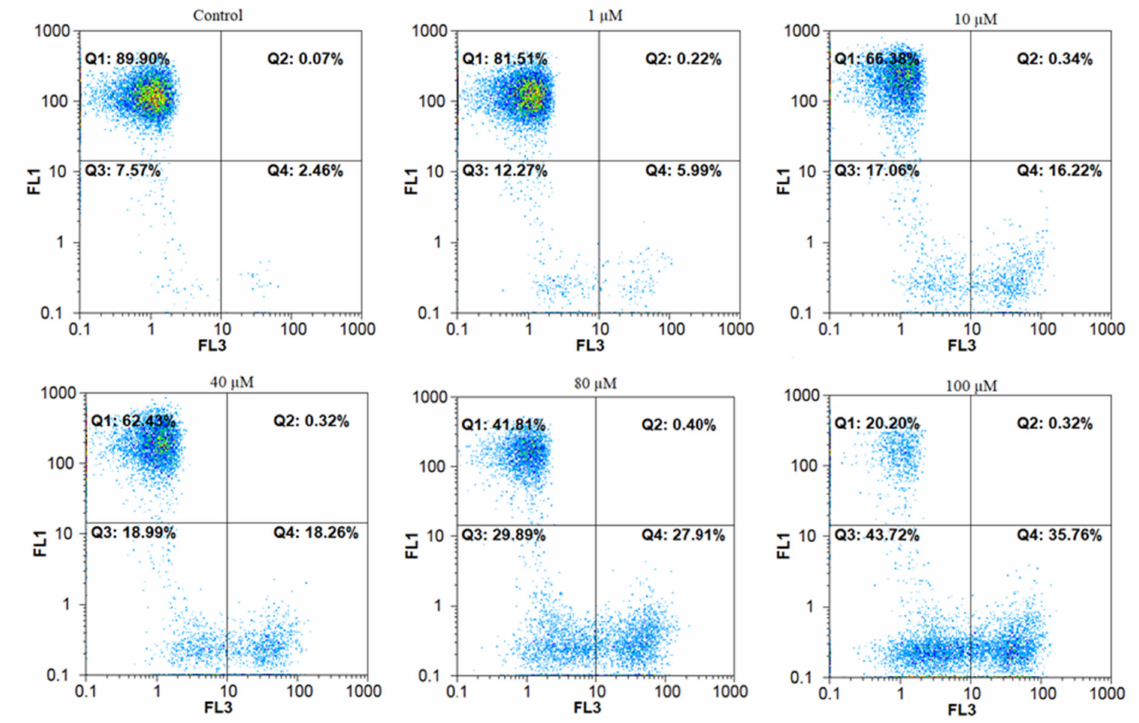
Figure 9. The cytotoxic effect after AGS cell line treatment with 3 tested using flow cytometry. FL1 channel represents 536/40 filter, FL3 channel 675/20. Fluorochromes were excited by blue laser (488/50